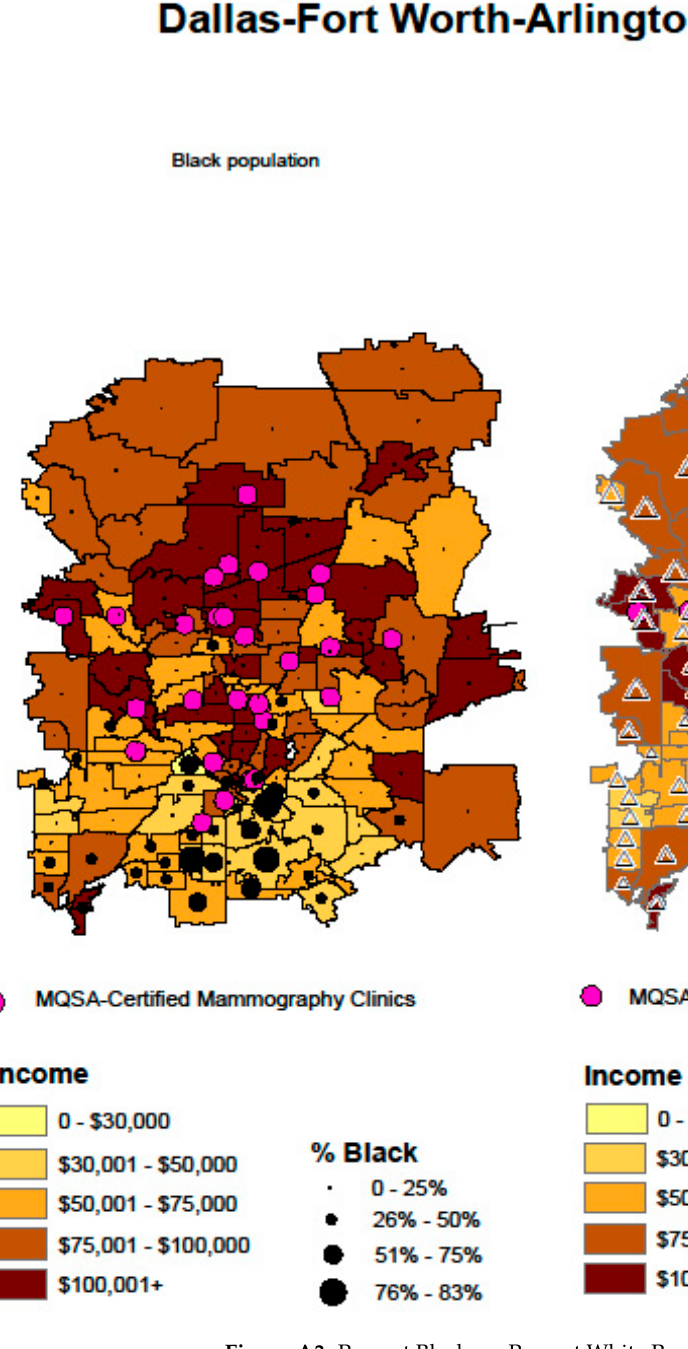
Figure A3. Percent Black vs. Percent White Population, MQSA Certified Mammography Clinics, and Income by ZIP Code Tabulation Area: Dallas-Fort Worth-Arlington Metro Area.